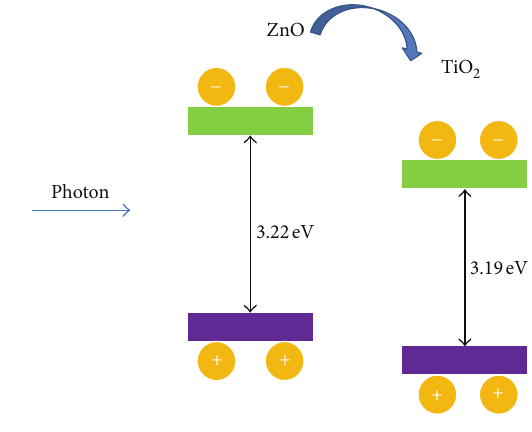
Figure 6: A schematic diagram of the electron and hole transfers for the ZnO/TiO 2